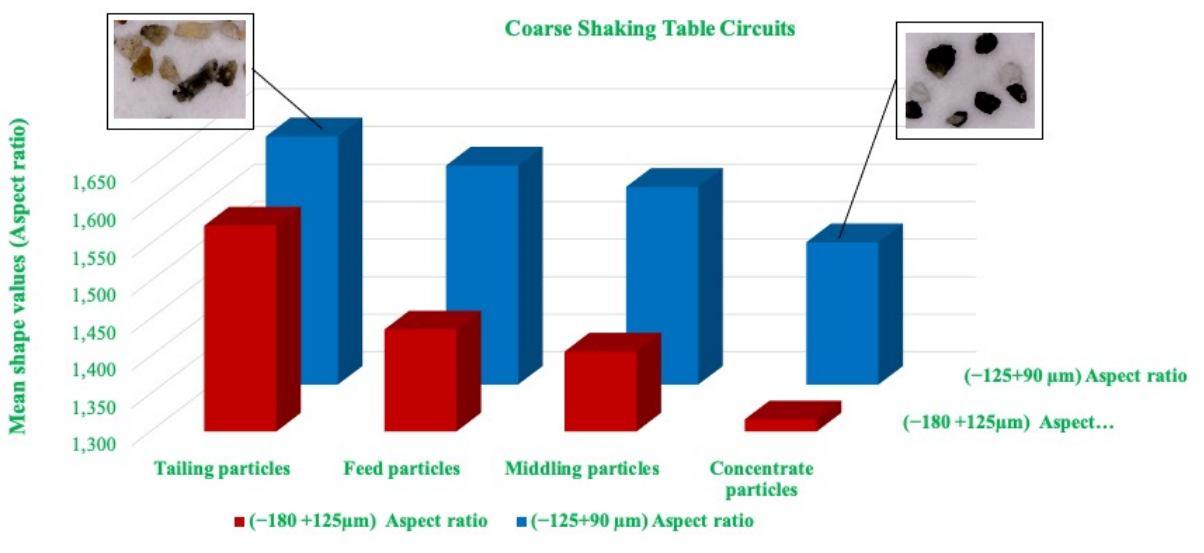
Figure 32. Average aspect ratio values determined by DIA for coarse shaking table circuit of chromite ore (modified from [107]).